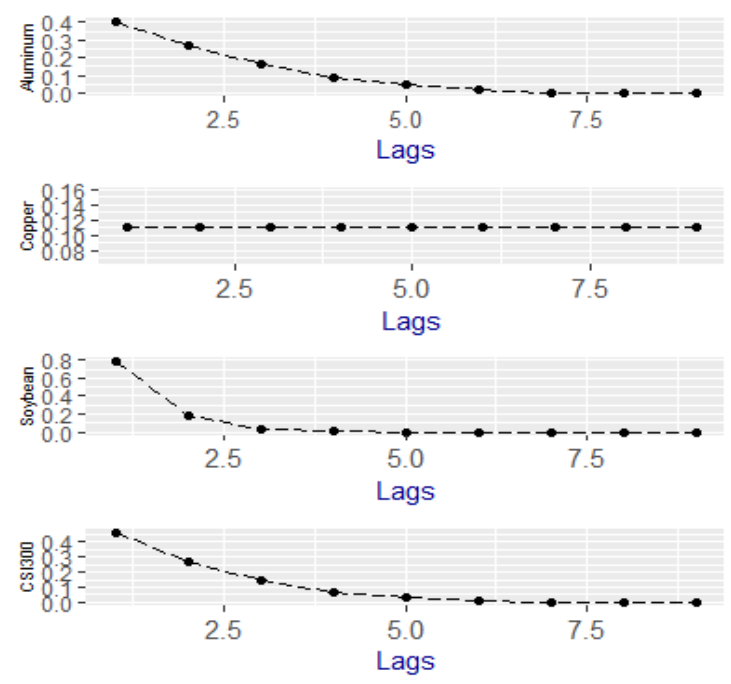
Figure 3. Exponential weighting function.